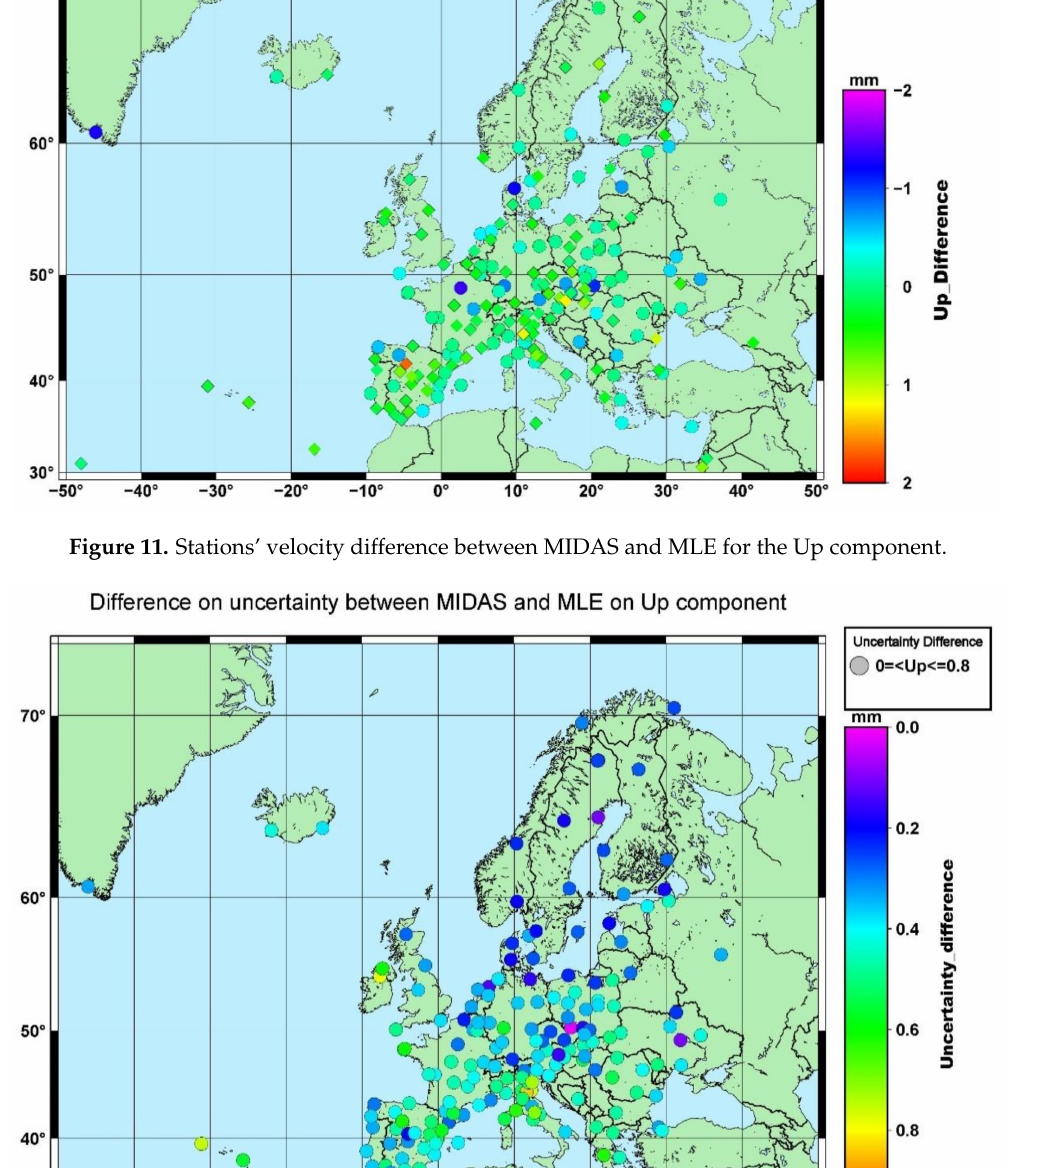
FLRS, FUNC, and MOPI, their values being 0.58 mm, 0.453 mm, and 0.428 mm. The velocity between MLE and MIDAS is at a sub-millimetre level for the Up com- ponent, excepting 4 stations (SPRN, MOPS, MLVL, and QAQ1), with a difference around 1.2–1.1